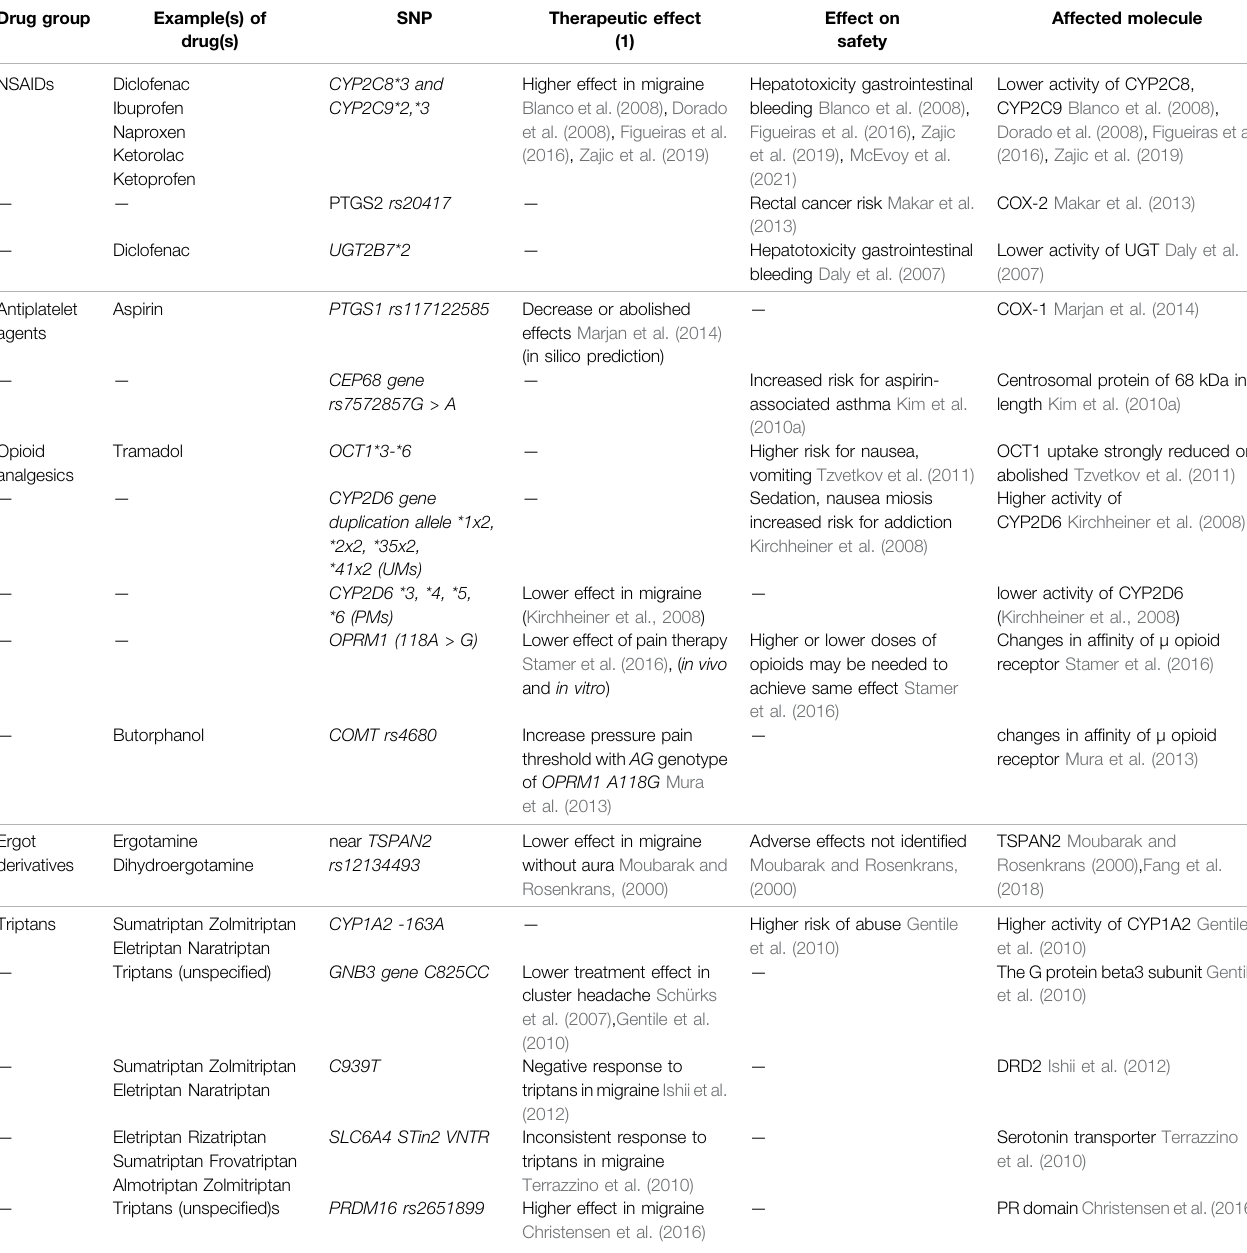
TABLE 3 | Important pharmacogenetic markers in treatment of acute primary